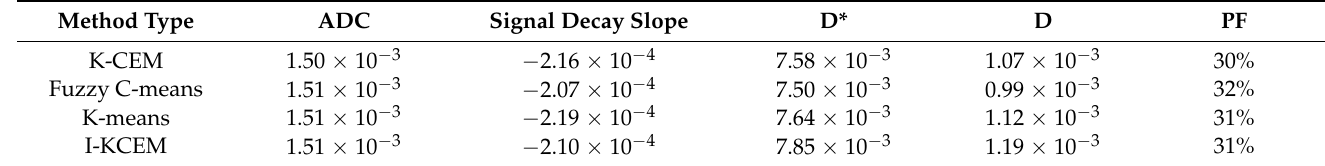
Table 2. Results of applying different detection methods to a non-mass tumor.